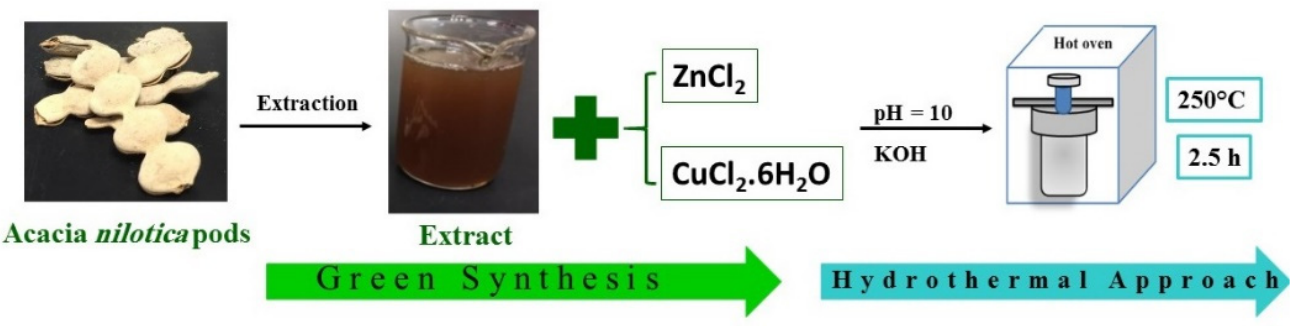
Table 1. Sample codes and corresponding volumes of precursors (mL).